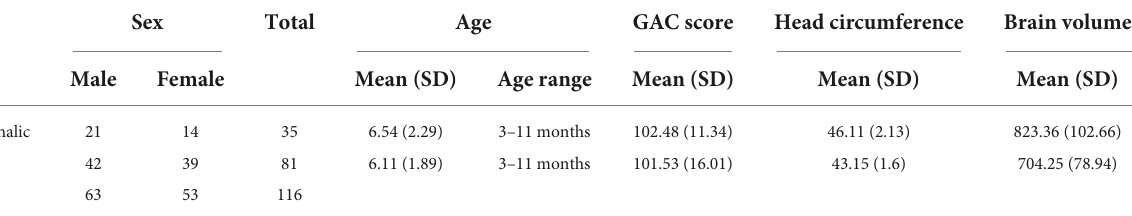
TABLE 1 Characteristics of control and macrocephalic infants.